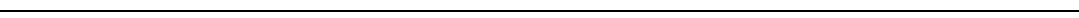
Fig. 10 BAD-LAMP expression in tumour-associated pDCs correlates with low IFN- α production. a ( left ) Flow cytometry pDC gating strategy on both PBMC ( top ) and tumour ( bottom ) is shown. pDCs (BDCA2 + ; CD123 + ) were segregated from conventional dendritic cells (Lin − , MHC II high ) after identi fi cation of live hematopoietic cells (CD45 + Live Dead − ). ( right ) CD123 + /BDCA4 + pDCs from blood ( black ) or from primary breast tumours ( red ) were further analysed for BAD-LAMP and MHC II expression. Data are representative of three patients. b Freshly isolated pDCs from healthy donors were treated for 16 h with tumour supernatant either devoid of (snTUM − ) or enriched in (snTUM+) TNF and TGF- β . ( left ) BAD-LAMP and MHC II histogram plots from FACS staining at steady state ( black line ) or 24 h ( dashed line ) after CpG-A treatment. Full grey histogram represents isotype control. Data are representative for fi ve independent experiments performed with eight different tumour supernatants. ( right ) Levels of BAD-LAMP shown as MFI from FACS intracellular staining in pDCs pre-treated with snTUM- ( dashed line ), snTUM + ( red line ) or with medium ( black lines ). MFI ± s.d. from fi ve independent experiments. c Freshly isolated pDCs from heathy donors were treated for 16 h with tumour supernatant either devoid of (snTUM-; black) or enriched in (snTUM+ ; red) in TNF and TGF- β . 2D FACS analysis of intracellular staining for IFN- α and TNF cytokines at different times after CpG-A stimulation. Data are representative for three independent experiments. d IFN- α ( top ) and TNF ( bottom ) production was monitored by ELISA at different times of CpG-A stimulation. Graphics represent cytokines concentration ± s.d. from fi ve independent experiments minimum. Eight different sets of tumour supernatants have been tested. e IFN α 2 ( left ) and TNF ( right ) mRNA expression in CAL-1 electroporated with BAD-LAMP siRNA ( dashed lines ) or scramble siRNA ( full lines ) and stimulated for indicated times with CpG-A. CAL-1 were treated either with TNF + TGF- β ( coloured ) or with medium ( black ). Raw data have been normalised to housekeeping gene (GAPDH) and graphics represent fold ± s.d. compared to non-stimulated cells from two